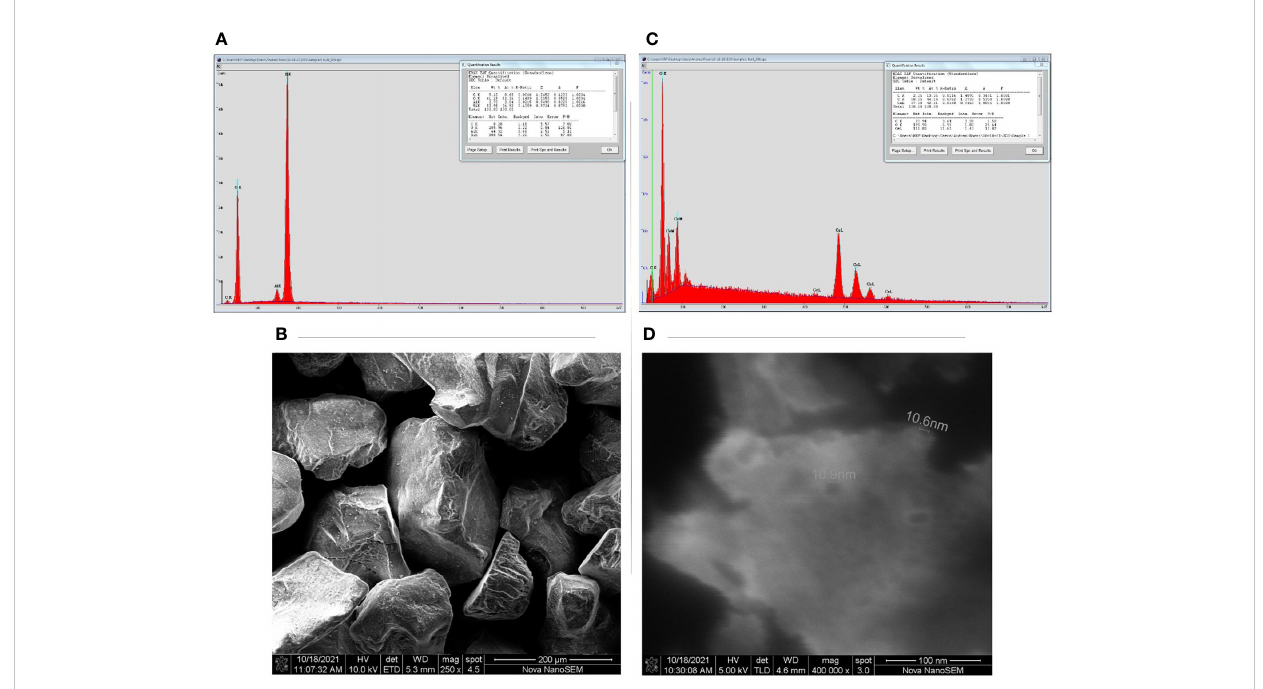
FIGURE 1 Scanning electron microscope images (SEM) and energy disruptive X-ray (EDX) peaks of sand and cerium oxide nanoparticles (CeO 2 NPs): (A) Sand EDX peaks, (B) Sand SEM, (C) CeO 2 -NPs EDX, (D) CeO 2 -NPs